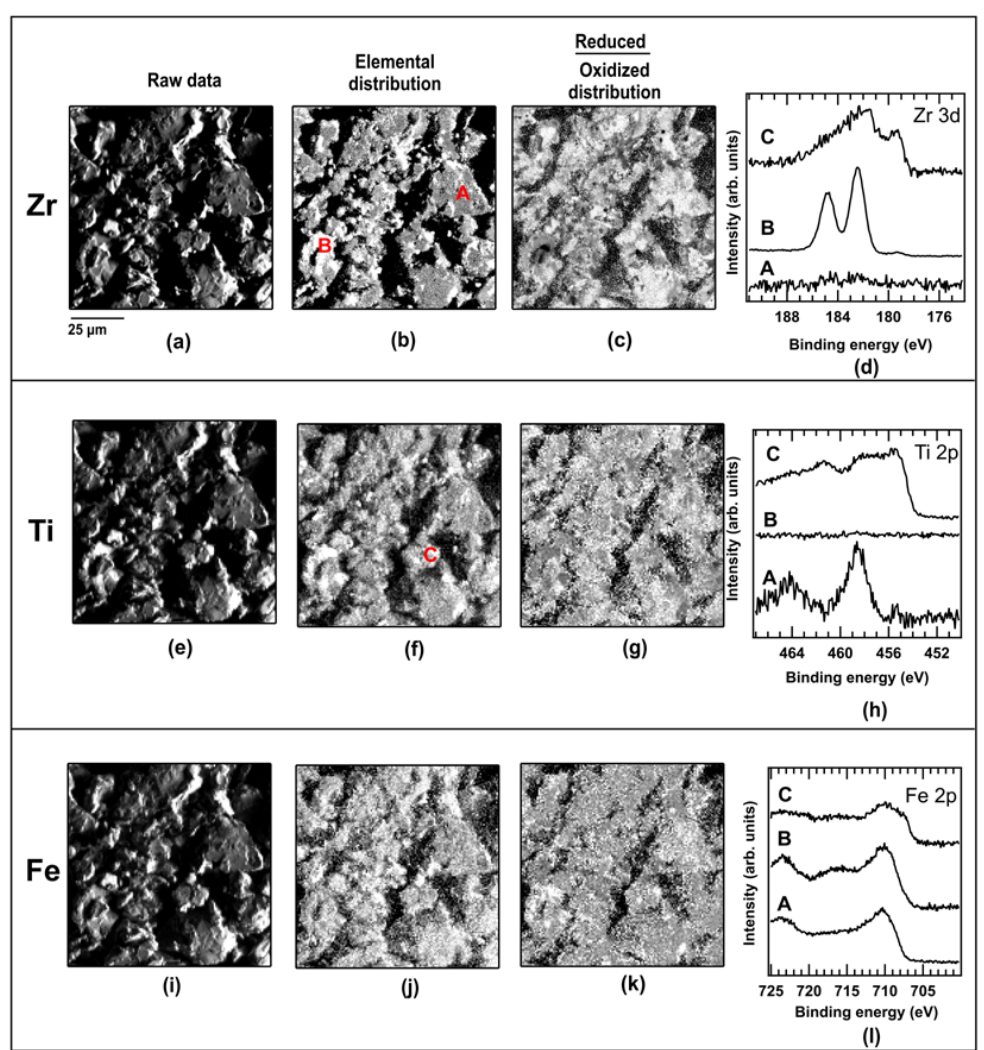
Figure 5. Element distribution and spectra of Ti, Fe and Zr in hydrogenated TiFe + 4 wt.% Zr. Zr ( a – d ), Ti ( e – h ), Fe ( i – l ). Raw data: ( a , e , i ), Elemental distribution ( b , f , j ). Reduced/oxidized distribution ( c , g , k ). Spectra ( d , h , l ).